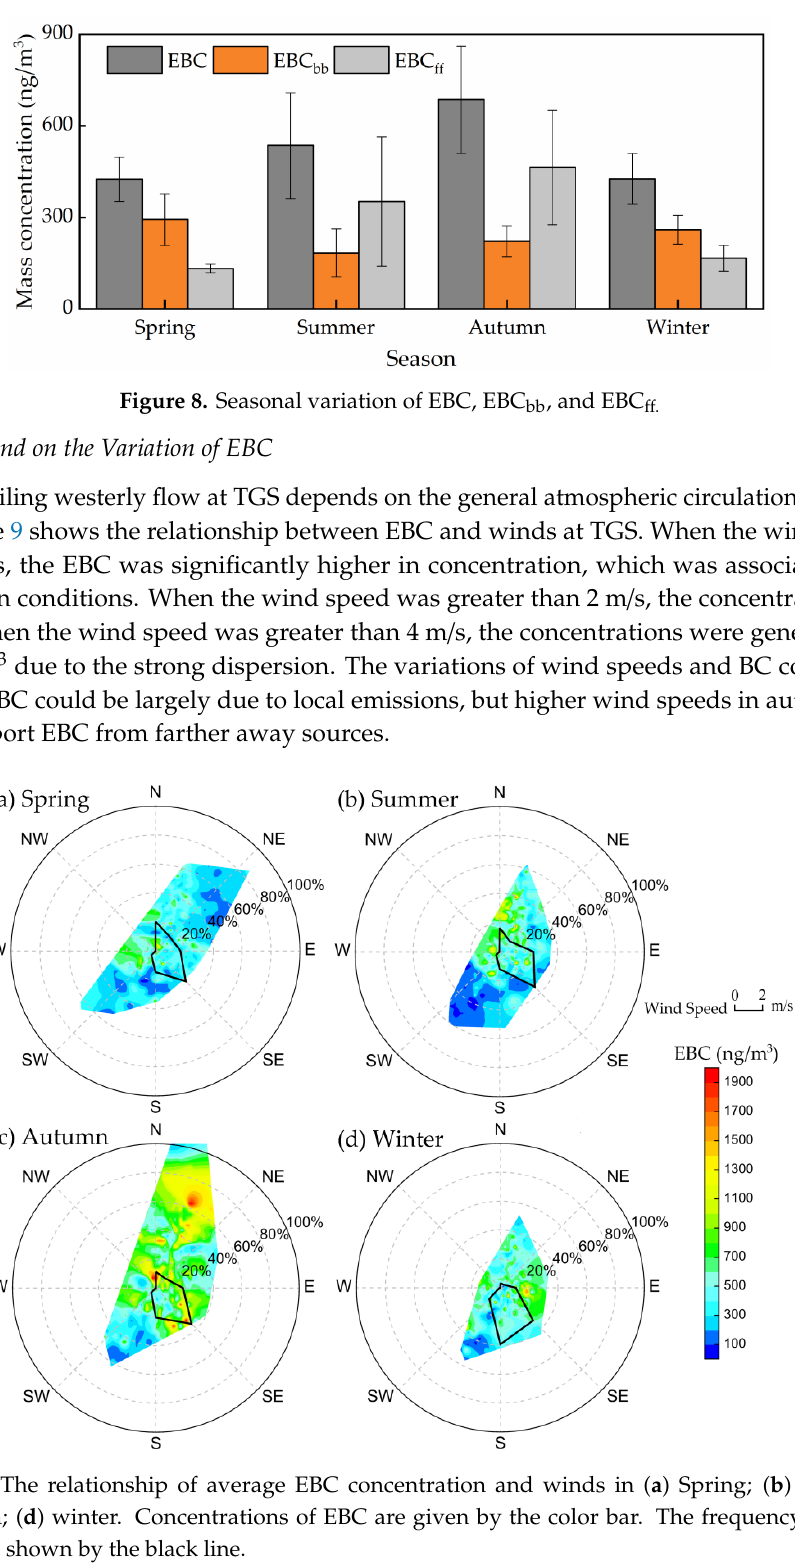
Figure 7. The daily mean concentrations of EBC ff and EBC bb.